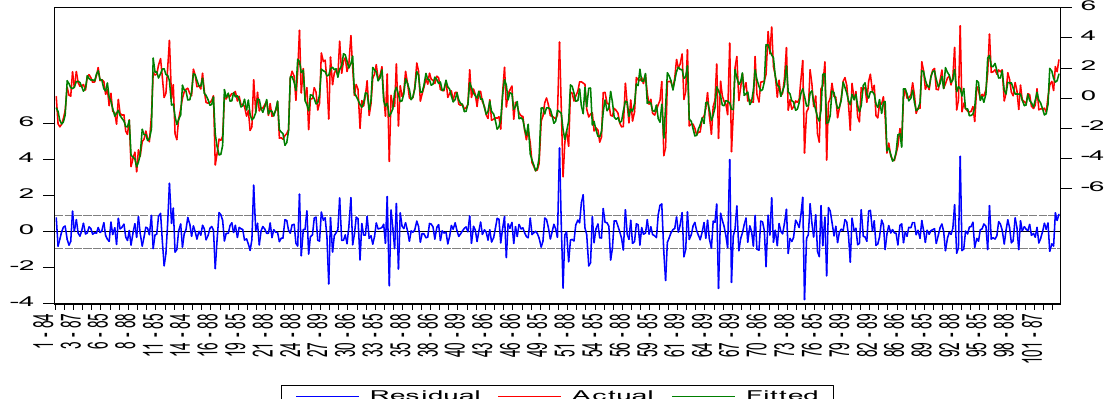
Fig. 1. Comparing the results of forecasted versus actual